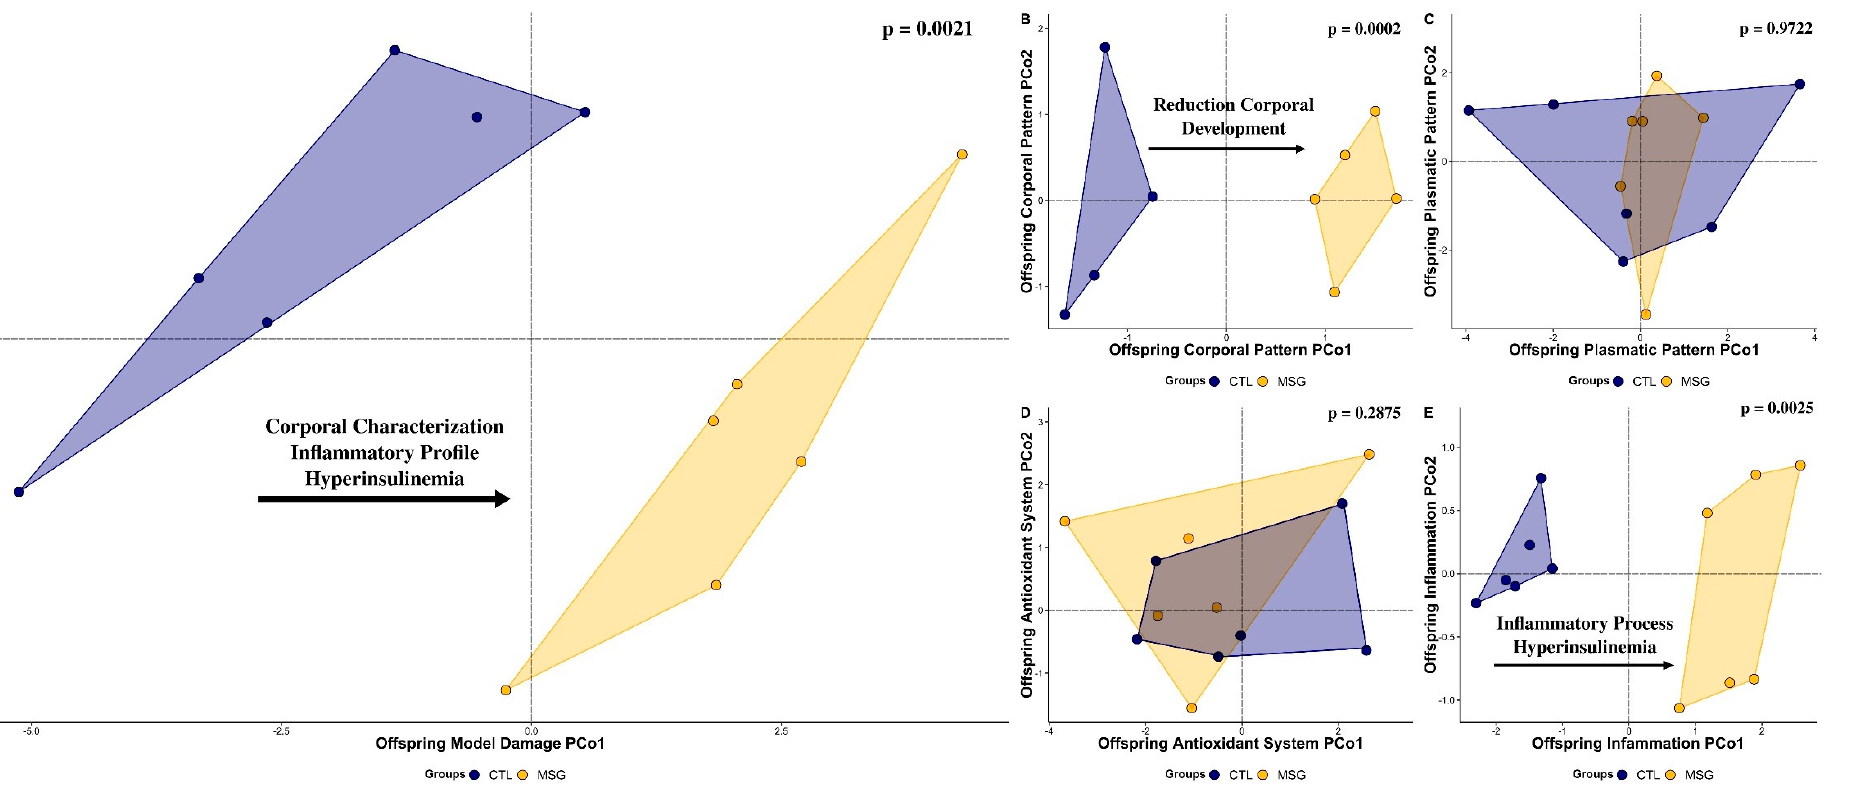
Figure 11. Graphical representation in scatterplot form of the multivariate relationships of the principal coordinates analysis (PCoA) of the animals to the PND15. ( A ): General Model Damage (all data); ( B ): corporal pattern; ( C ): plasmatic pattern; ( D ): antioxidant system; ( E ): inflammation. The CTL group is represented in blue and MSG group is represented in yellow. All data: principal coordinates analysis.